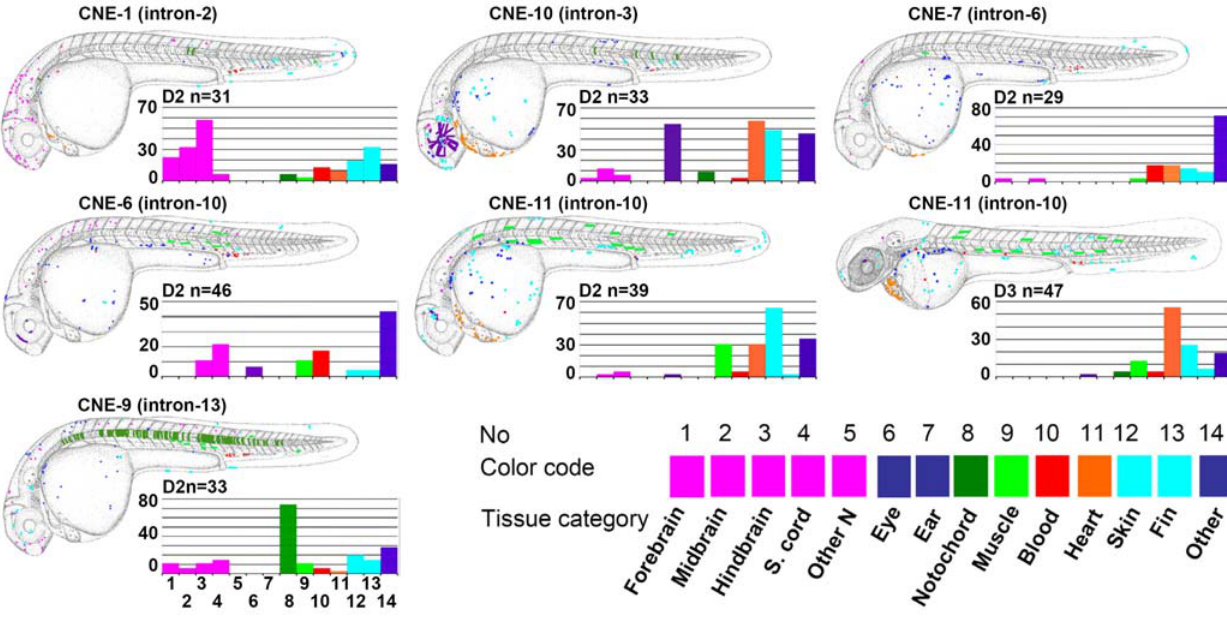
Figure 3. Sites of GFP Expression Induced by GLI3 -Associated CNEs in Zebrafish Embryos. Upregulation of GFP by individual GLI3 -associated CNEs (indicated by name and location in a GLI3 -intron) depicted in schematic representations of day two, 24–33 hpf (D2) or day 3 (D3) embryos. N=the total number of positive embryos per CNE. Categories of cell type that were positive for a given element are color coded, and each dot represents a single GFP positive cell. These are mapped onto camera lucida drawings of the zebrafish embryo, and the overall results are overlaid. The percentage of positive embryos that show expression in each color coded tissue category are shown on the bar charts.